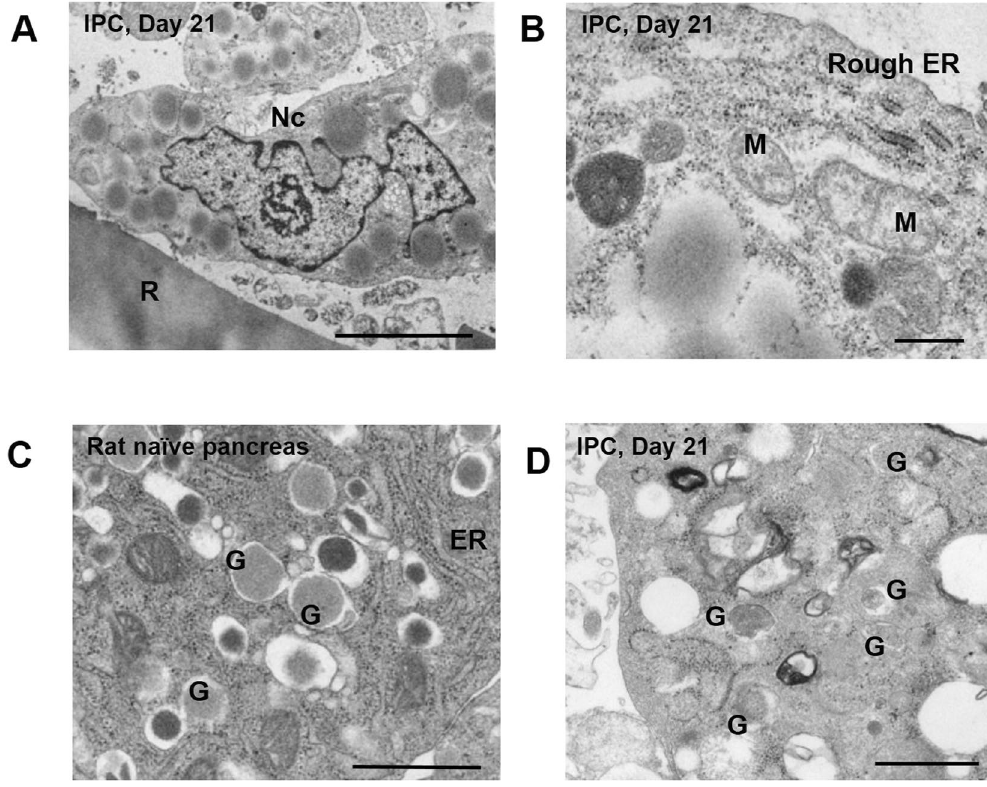
Figure 3. Electron microscopic images of microstructures in IPCs. (A) Generated 3D cultured IPCs at day 21 showed clear nuclei. Nc: nucleus, R: RCP petaloid μ -piece. Scale bar, 5 μ m. (B) Generated 3D cultured IPCs at day 21 also showed organelles. M: mitochondria, ER: endoplasmic reticulum. Scale bar, 1 μ m. (C) Control: section from naïve rat pancreas. Naïve rat islets show dense cystic microstructures. ER: endoplasmic reticulum, G: secretory granule. Scale bar, 1 μ m. (D) The same microstructures morphologically resembling secretory granules existed in generated IPCs at day 21. G: secretory granule. Scale bar, 1 μ m.